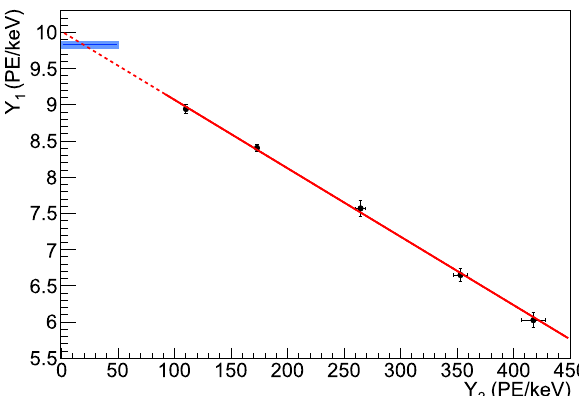
Fig. 16 S1 vs. S2 yield for 241 Am calibration runs taken in double- phase mode at 100 ≤ E d ≤ 1000 V/cm. The red line is the best fit according to the model of Eq. 10. The horizontal blue band shows the = ( 9 . 80 ± 0 . 05 S1 yield measured at null field Y 0 stat ) PE/keV, where 1 a measurement of Y 2 is not